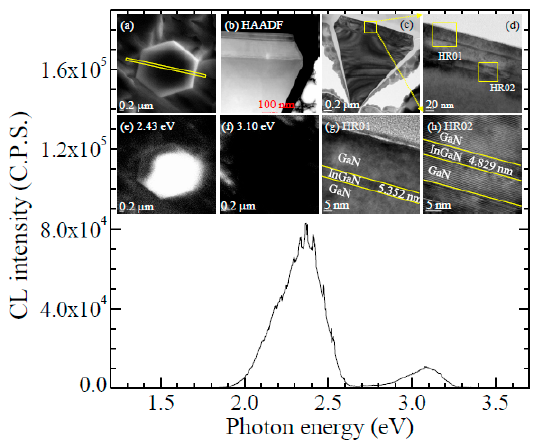
Figure 7. The CL spectrum of the microdisk double QWs. ( a ) The top-view of the microdisk with the cleavage plane along [1 1 00] direction (the scale bar is 0.2 μ m). ( b ) The high angle annular dark field TEM image. ( c ) and ( d ) The TEM images for the microdisk double QWs with a scale bar of 0.2 μ m and 20 nm. ( e ) and ( f ) Shows the CL images for photon energies of 2.43 eV, 3.10 eV. ( g ) and ( h ) Show the high resolution TEM images of the yellow squares in ( d ) which is denoted as HR01 and HR02. The scales bars are 5 nm.